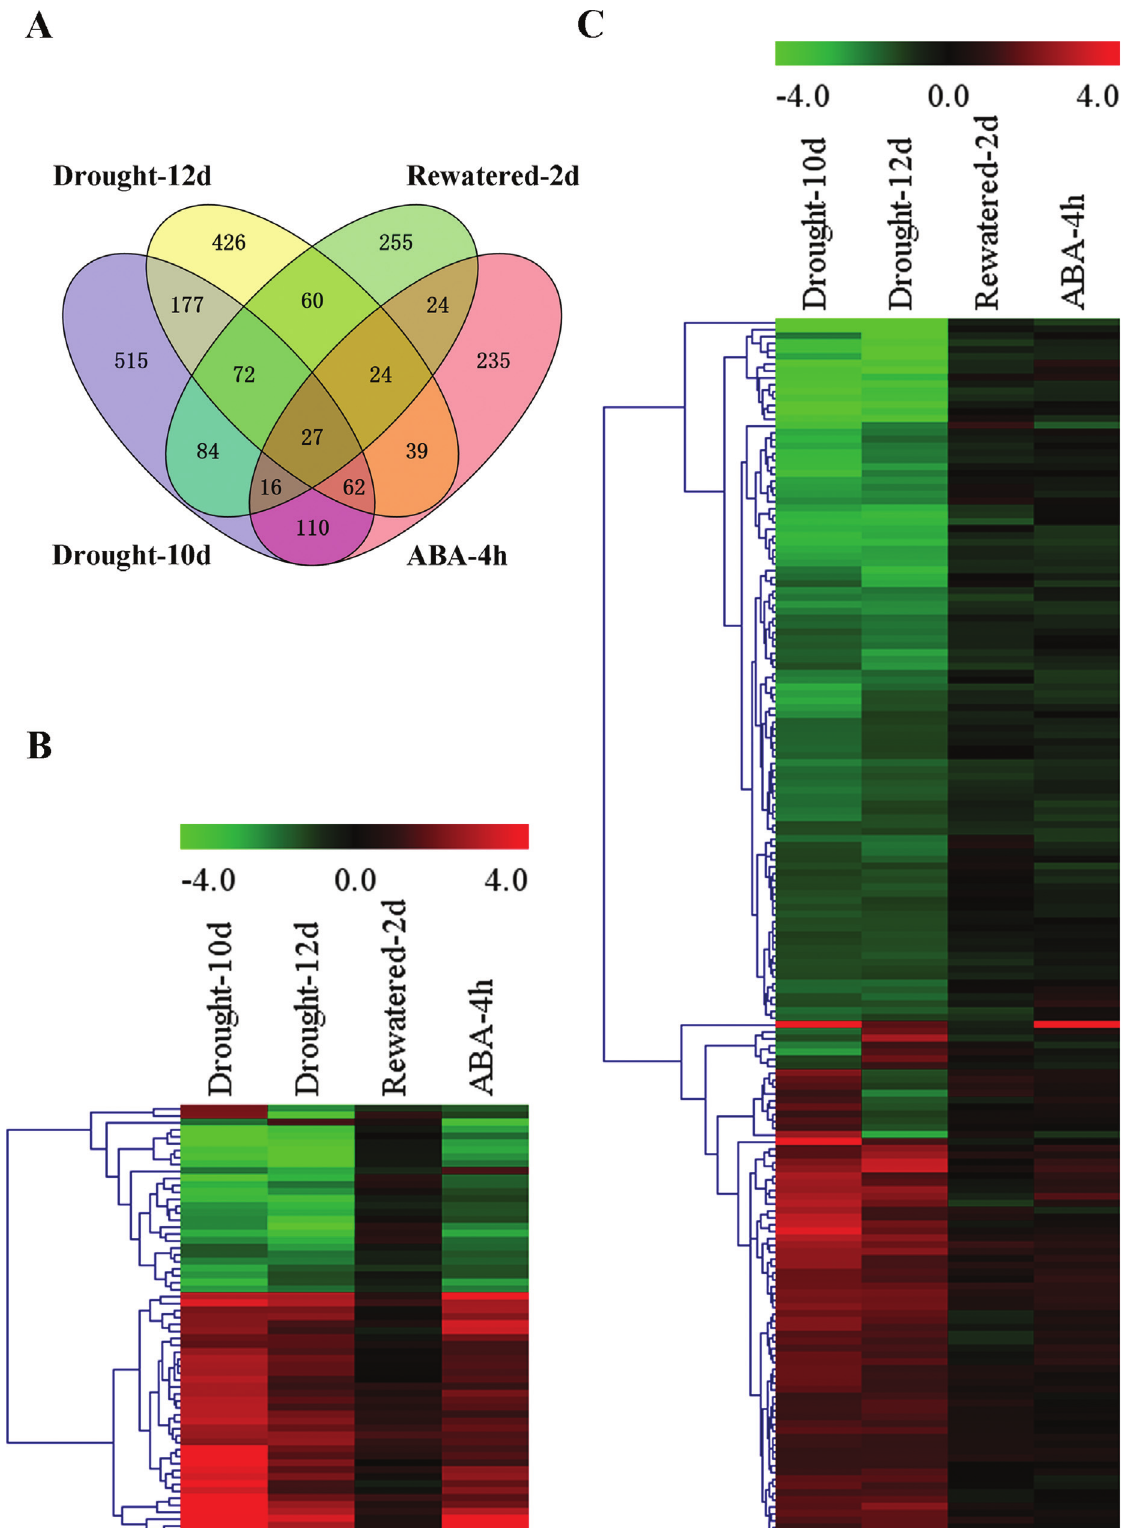
Figure 1 - Venn Diagram and Clustered Heatmap of DEGs. (A) Venn diagram of DEGs. Venny (http://bioinfogp.cnb.csic.es/tools/venny/index.html) was used to compare DEG lists with Venn diagrams. (B) Clustered heatmap of ABA-dependent DEGs. (C) Clustered heatmap of ABA-independent DEGs. Each row in the heatmap represents a gene, and each column represents a treatment. Red and green indicate up-regulated and down-regulated ex- pression,respectively.TheEuclideanformulawasusedfordistancecalculation,andacompletelinkageclusteringanalysiswasperformedonDEGs. The log 2 ratios of the expression of DEGs in each sample were used for a cluster